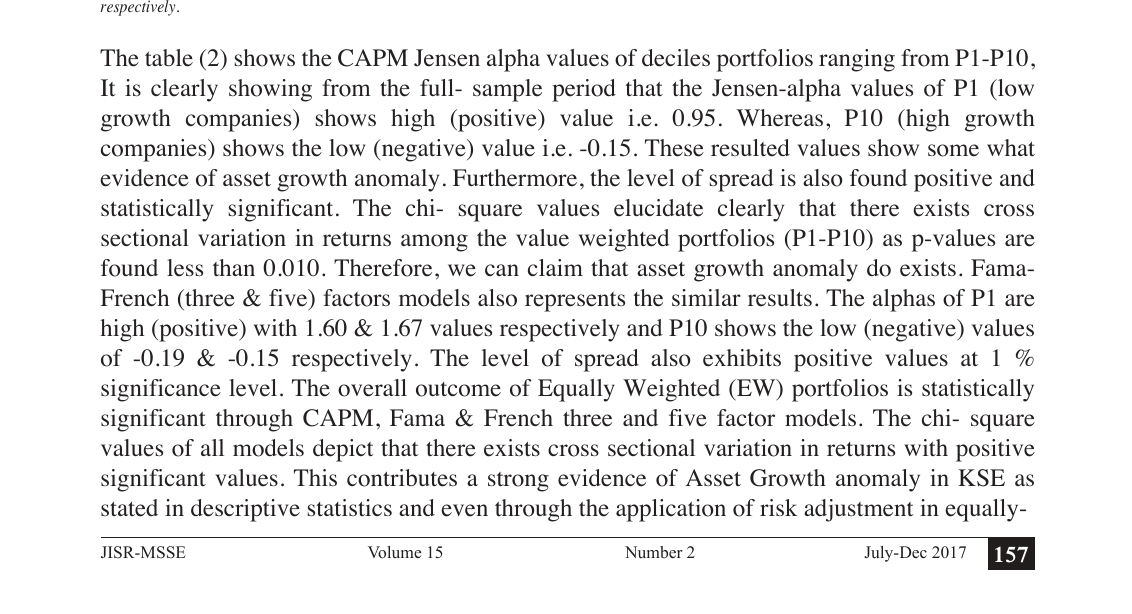
The table represents the value weighted asset growth in deciles portfolios of sample period from Jan 2000-Dec 2010.The single (*) means 10% chance of rejecting true null hypothesis that there exists no difference in P1 & P10 alphas. On the other hand (**) and (***) shows 5% and 1%